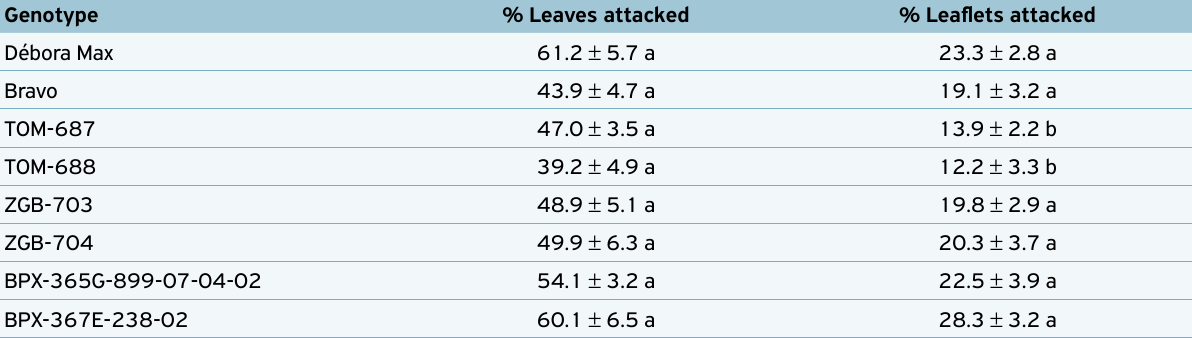
Table 1. Mean ( ± standard error) of the proportion of leaves and leaflets of different tomato plant genotypes with contrasting contents of allelochemicals, attacked by L. trifolii . Genotype % Leaves